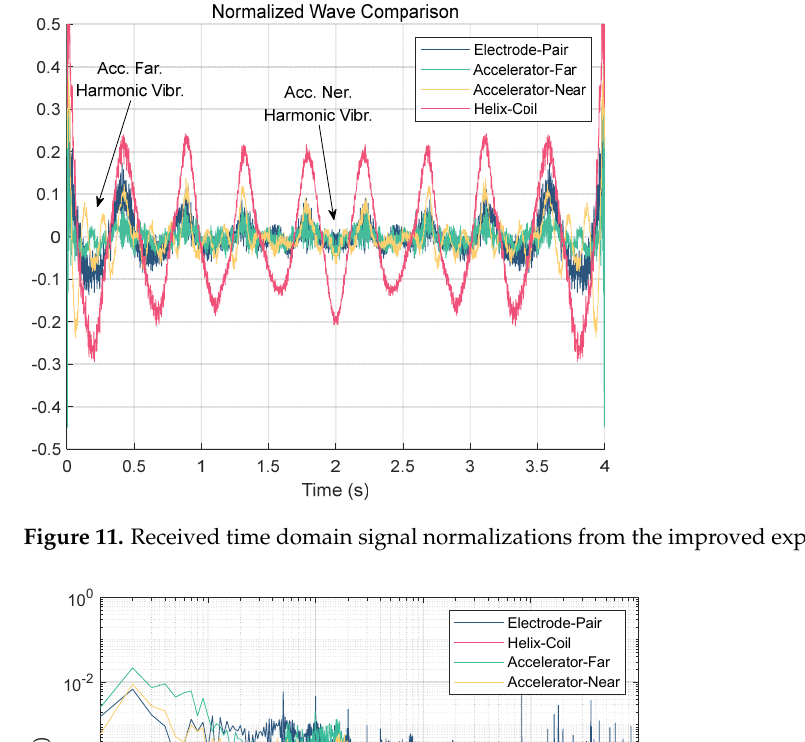
( c ) Figure 12. Received frequency domain signals of the improved experimental section. ( a ) Low vibra- tion speed. ( b ) Medium vibration speed. ( c ) High vibration speed.